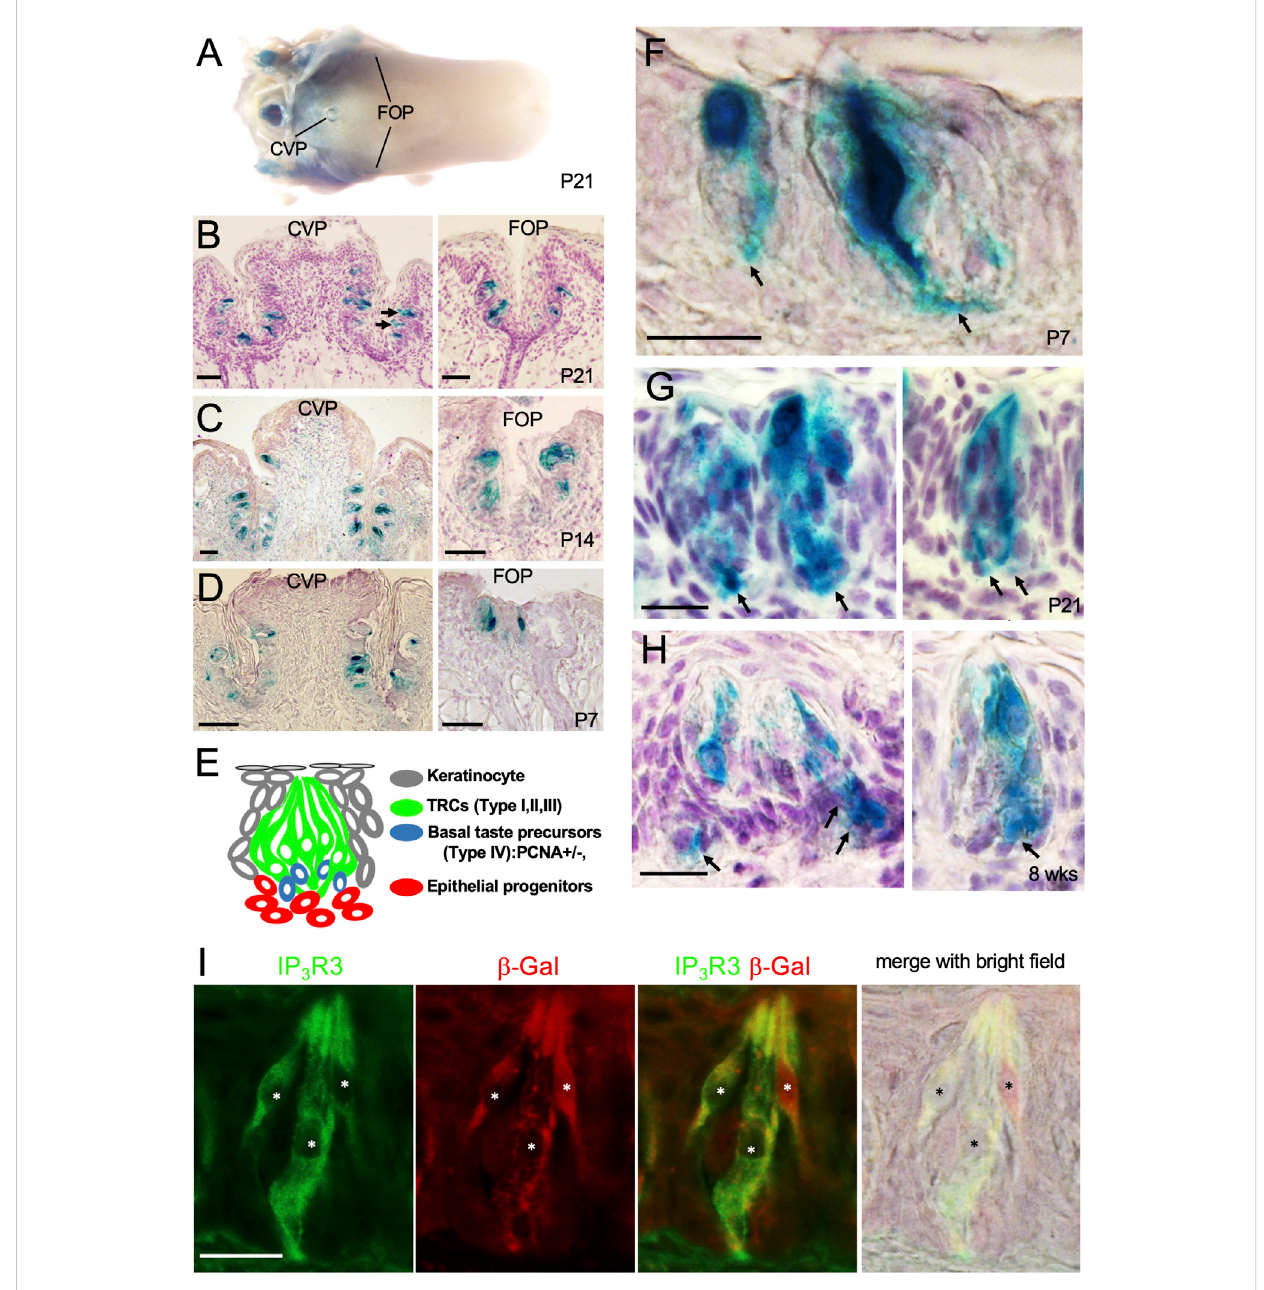
FIGURE 5 Eya1 is expressedin a subset of taste cells and some basal progenitors after birth. (A) Whole-mount X-Gal staining of the tongue in Eya1 lacZ/+ mice at P21. (B) Sections of X-Gal stained tongue in (A) showing the CVP and FOP regions. (C, D) X-gal stained sections of CVP and FOP regions at P14 (C) and P7 (D) . (E) Schematicdrawing showingdifferenttypes oftaste bud cells. (F – H) X-Gal stained sections showing β -Gal + cellsin theCVPtaste buds atP7 (F) , P21 (G) , and 8 weeks (H) . Arrows point to basal progenitors. (I) Co-immunostaining for β -Gal and IP 3 R3 in taste buds at 8 weeks. Asterisks indicate IP 3 R3 + cells are also β -Gal + . Scale bars: 50 μ m (A – D) and 20 μ m (F – I)